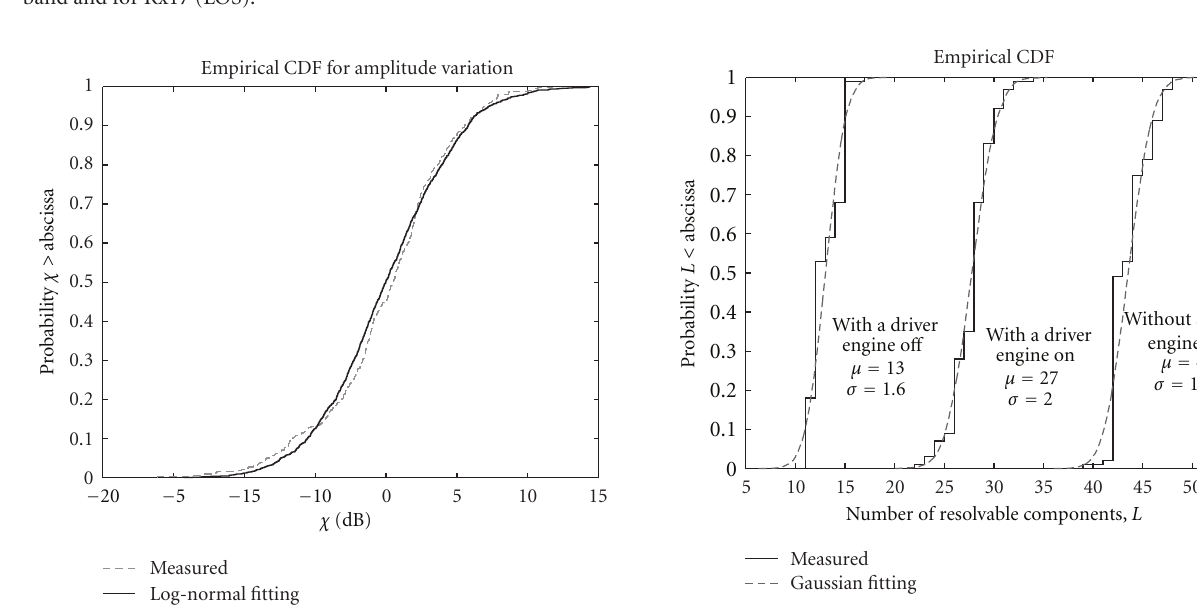
Figure 6: CDFs of the amplitude variation over the mean value of the path amplitude and the log-normal fitting curve for the ISM band and for Rx17 (LOS).